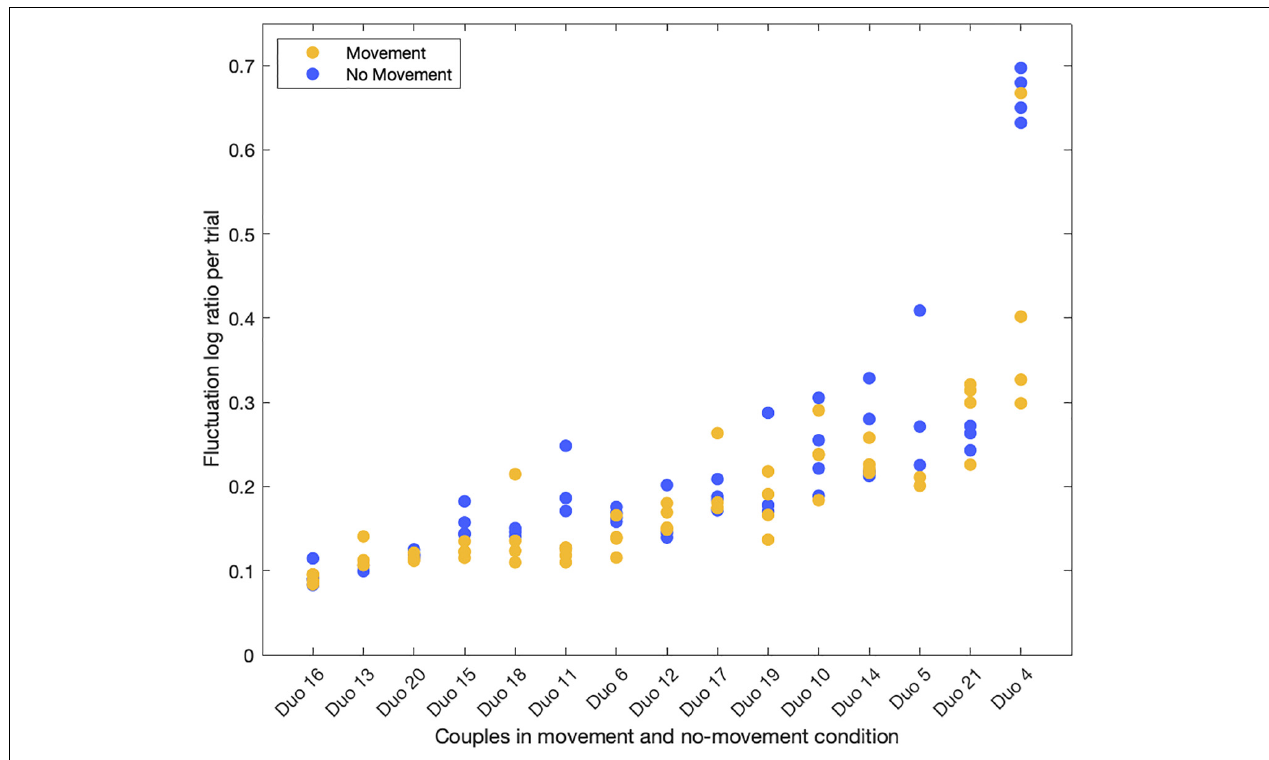
FIGURE 4 | Fluctuation errors per duo. The duos are ordered from smallest to largest average fluctuation error over the eight performance